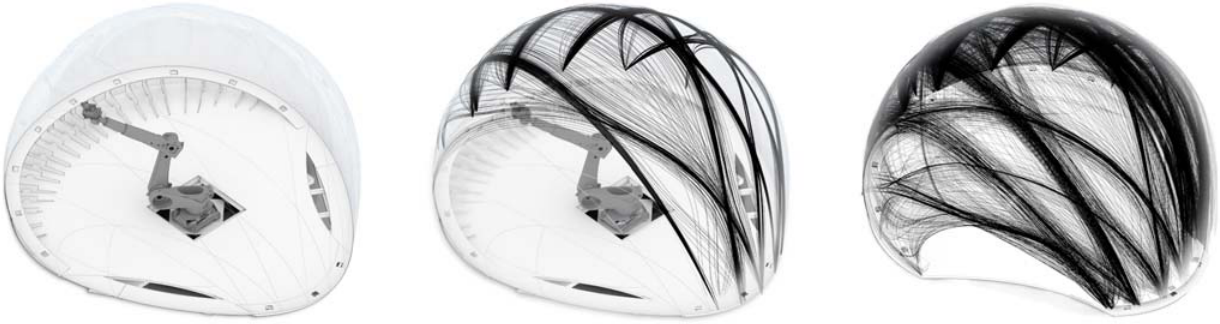
Figure 14: Construction method used for the ICD/ITKE research pavilion in 2014/15 © ICD/ITKE University of